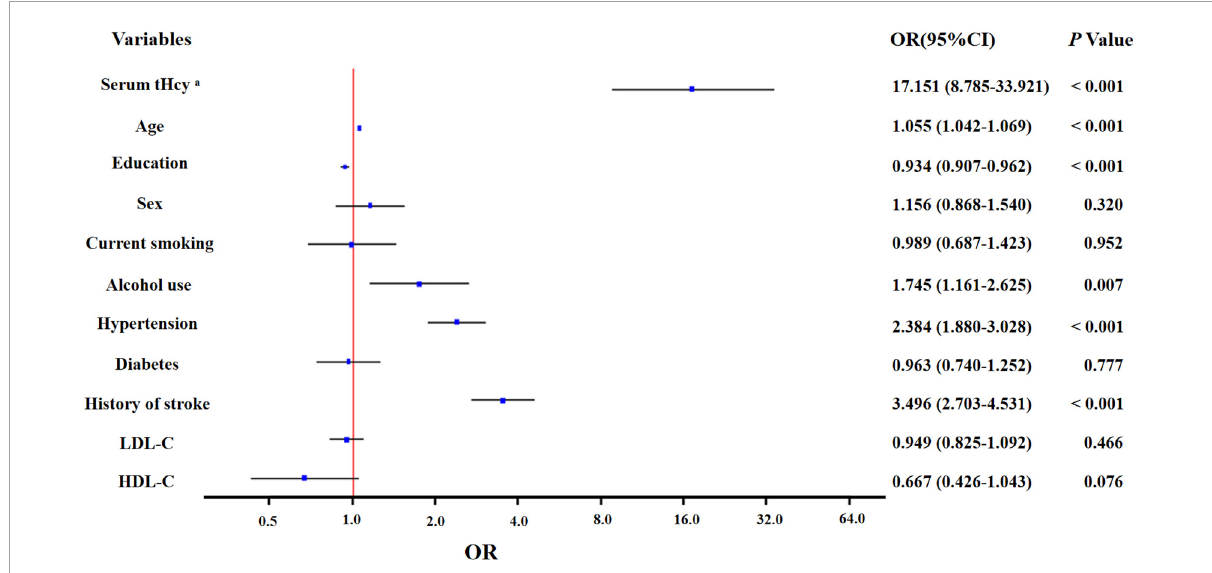
FIGURE2 Multivariate ordinal logistic regression analysis for the associated factors with total CSVD burden score. a The variable was transformed to log scale.